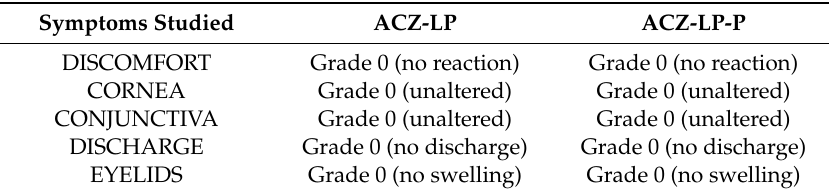
Table 7. Macroscopic evaluation of signs and symptoms in the in vivo tolerance study for liposomal